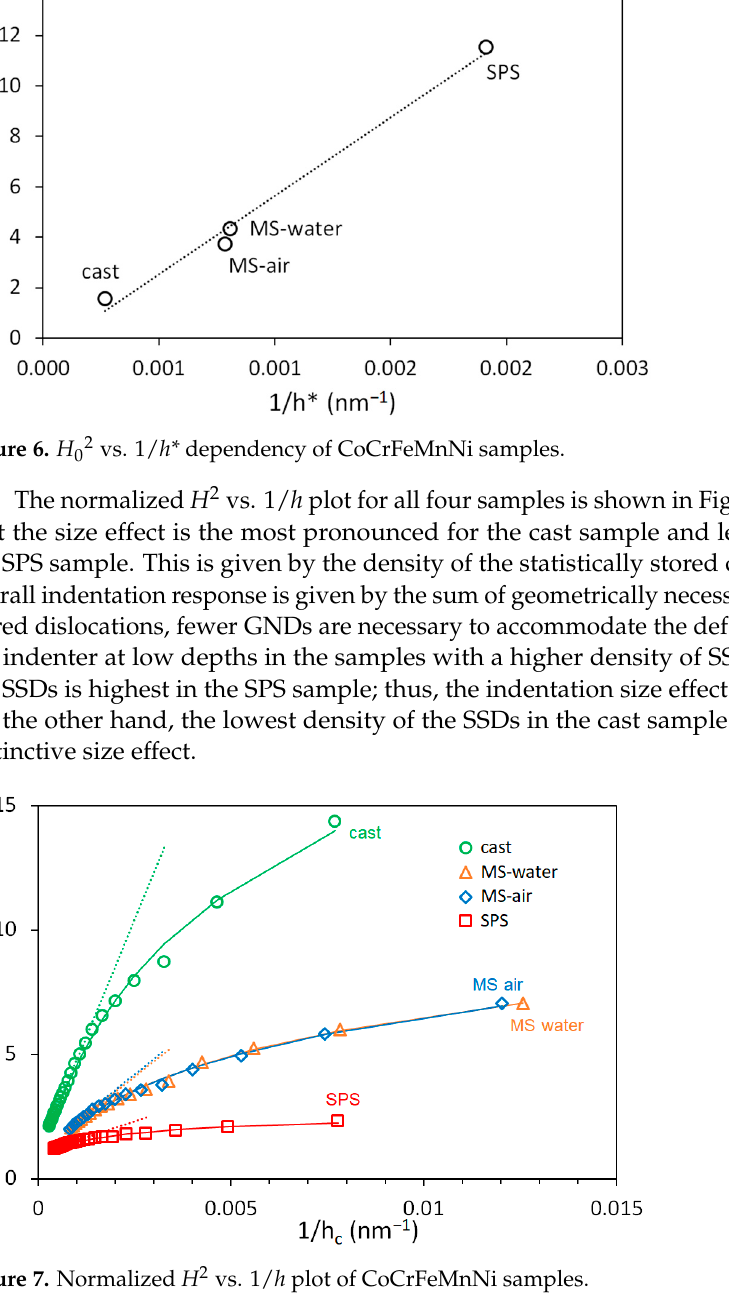
Figure 5. Depth dependence of hardness of CoCrFeMnNi samples: ( a ) cast; ( b ) MS-water; ( c ) MS- air; ( d ) SPS.